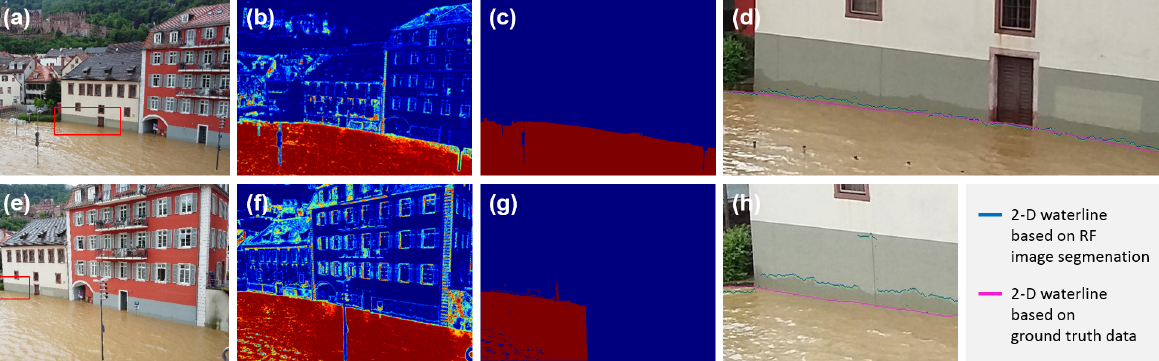
Figure 4. Segmentation results of two different flood images (top line: precision = 99.6%, recall = 95.6%; bottom line: precision = 98.5%, recall = 54.3%). (a, e) depict the original images. (b, f) show the probability maps after RF classification. (c, g) are the binary images of the finally classified water body after largest-component analysis. (d, h) show subsets of the extracted 2-D